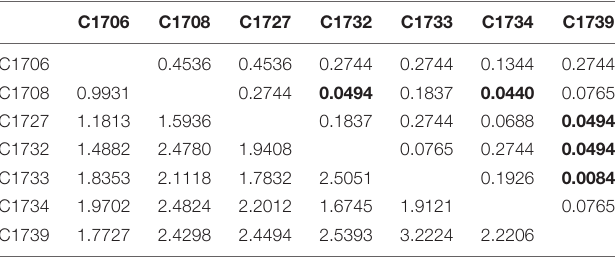
TABLE 5 | Pairwise PERMANOVA of global DNA methylation patterns between coral genets.